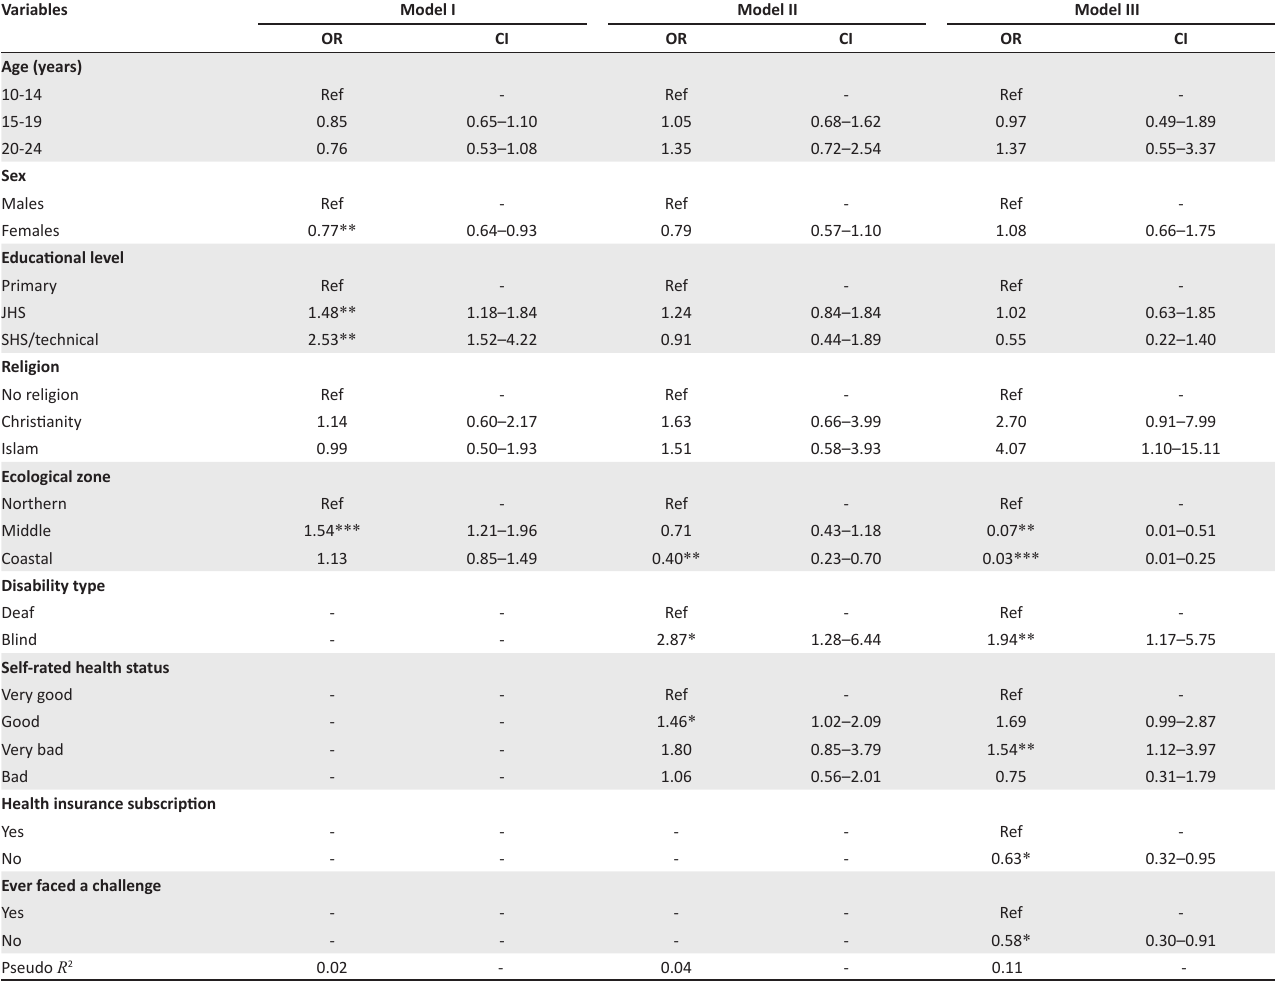
TABLE 5: Logistic regression analysis of sexual and reproductive health services